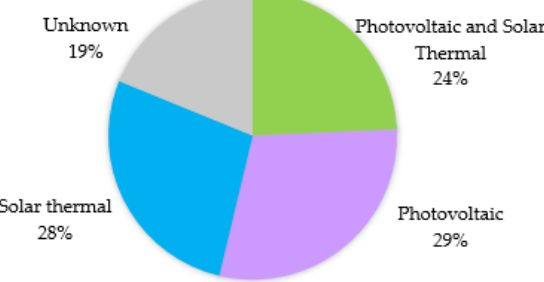
Figure 23. Share of installation of PV and solar thermal systems.